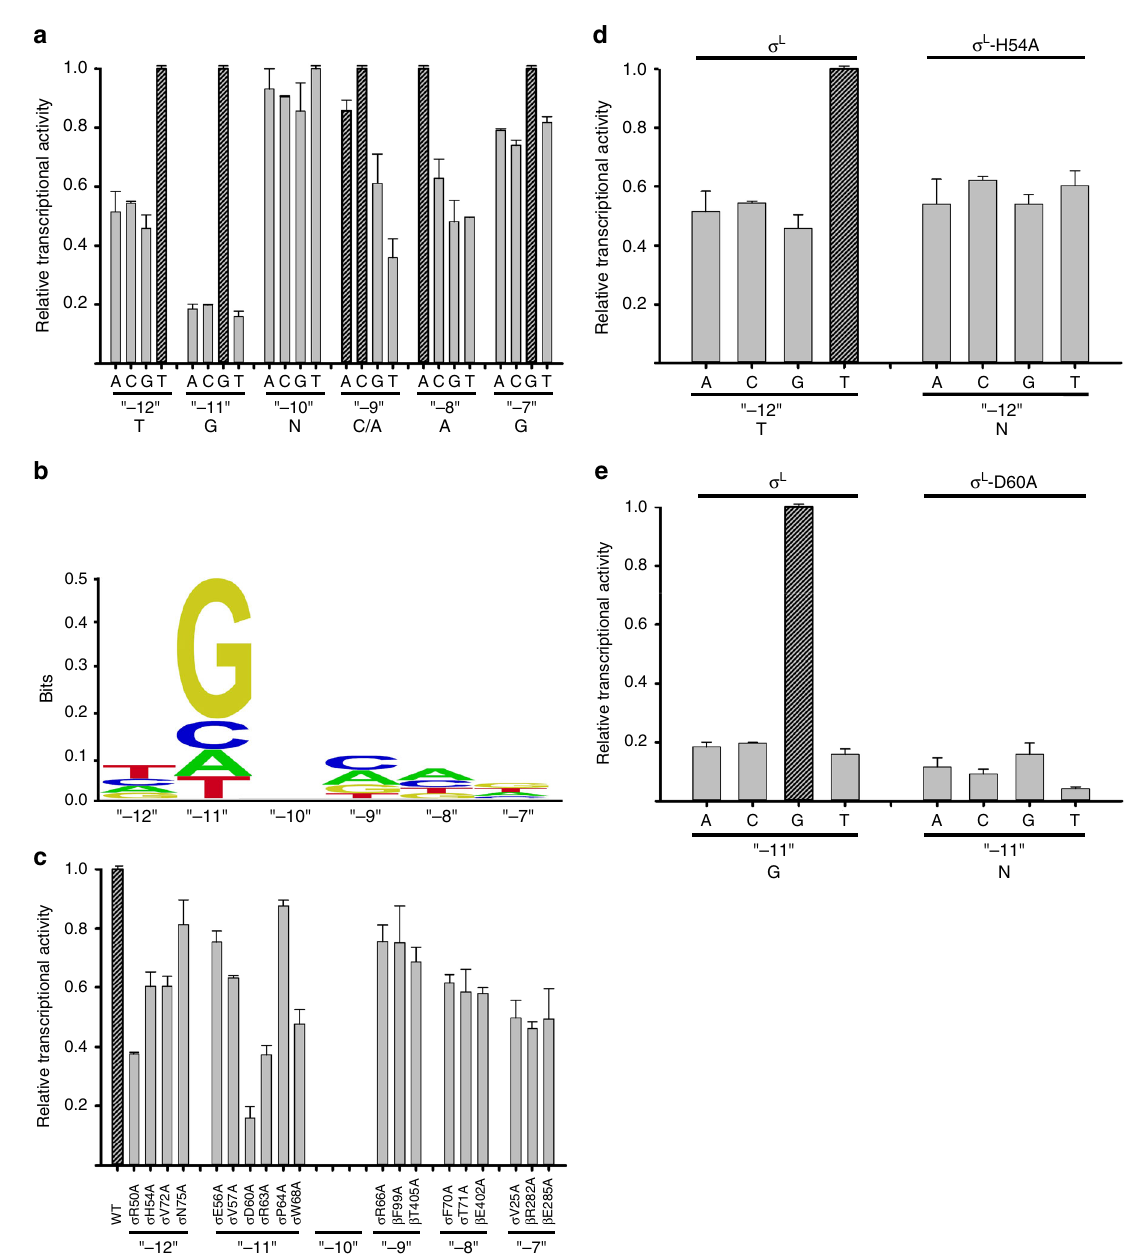
Fig. 6 Recognition by Mtb σ L of σ L -promoter -10 element: experimental data. a Systematic-substitution experiments de fi ning σ L -dependent promoter -10- element consensus sequence. Relative transcriptional activities of derivatives of σ L -dependent promoter P- sigL having all possible single base-pair substitutions at each position of promoter -10 element, “ -12 ” through “ -7 ” . Inferred consensus nucleotides are shown at the bottom, and data for inferred consensus nucleotides are hatched. Error bars, SE ( N = 3). b Sequence logo for σ L -promoter -10-element consensus sequence [generated using transcription data from ( a ) and enoLOGOS 71 (http://biodev.hgen.pitt.edu/enologos/); input setting “ energy (2) ” and weight-type setting “ probabilities ” ]. c Alanine-scanning experiments 41 demonstrating functional importance of observed amino acid-base interactions in recognition of σ L -promoter -10 element. Effects on transcription of alanine substitutions of σ L amino acids that contact σ L -dependent promoter -10 element, positions “ -12 ” through “ -7 ” (identities of contacting amino acids from Figs. 3 and 5). d , e Loss-of-contact experiments 42 – 45 indicating that σ L residues His54 and Asp60 determine speci fi city at position “ -12 ” and “ -11 ” , respectively. Left: transcriptional activity with wild-type σ L for all possible single base-pair-substitutions at indicated position (strong speci fi city for consensus base pair). Right: transcriptional activity of σ L derivatives having alanine substitutions (no speci fi city for consensus base pair). Error bars, SE ( N = 3). See Supplementary Fig. 6. Source data are provided as a Source Data fi le